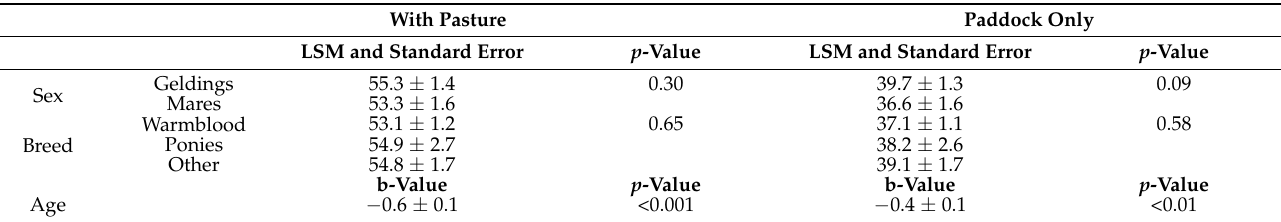
Table 1. Least Square Means (LSM), standard errors and p -values of the models divided in datasets with and without pasture.